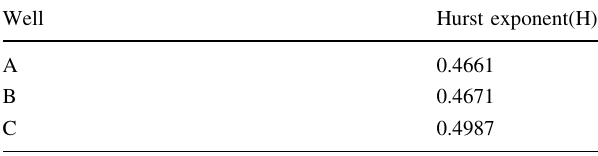
Table 6 Determination of fractal dimension in each of wells (A, B, and C) by log data D F (by box- Well Fahliyan counting thickness in the well (m)